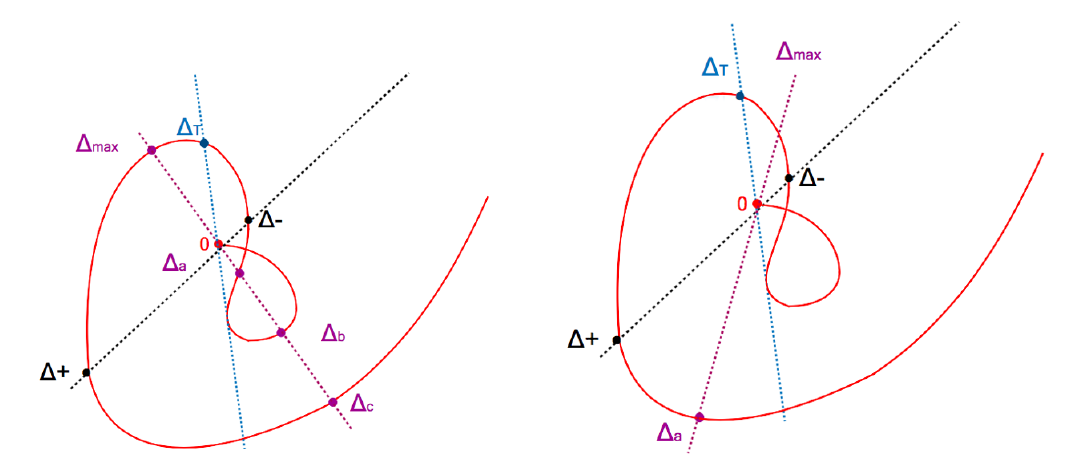
Figure 15 . There are two possible con(cid:12)gurations of the spectrum depending on where (cid:1) max lies with respect to (cid:1) T , which is the point where the line that passes through the origin and tangent to the curve below (cid:1) (cid:0) , intersects with the block curve. On the l.h.s. we have (cid:1) max > (cid:1) T , for which we conclude that either (cid:1) max +1 is between (cid:1) + and (cid:1) c , or that there is a light operator between